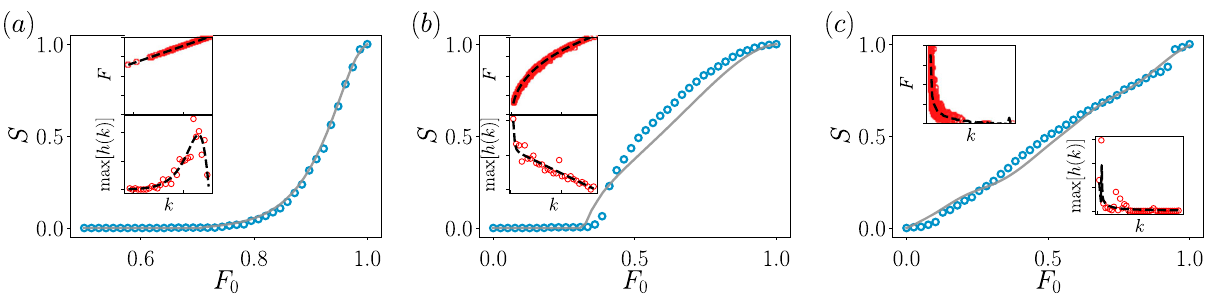
Fig. 6 Feature-enriched percolation of dynamical processes on top of real-world networks. In ( a ) mutualistic dynamics are given by Eq. (22), in ( b ) population dynamics from Eq. (23) and in ( c ) the biochemical dynamics (24) The main plots display the size of the largest connected component from simulations (markers) and its approximation given by the theory (lines). Insets show the data used to feed the Bayesian machine scientist (markers) and the resulting curves (dashed lines), used to calculate the degree-feature joint distribution (21). The output functions of the BMS are given in Supplementary Note 8. The feature is the value of the dynamical variable x i at the steady-state, normalized by its maximum value, i.e., F ¼ x i ð t ! 1Þ = max The range of F in all the insets is the unit interval. The range of max ½ h ð k Þ(cid:5) is arbitrary since its values depend on the binning to compute the histograms. All constants { τ i } are set equal to 1. The initial condition is a uniform distribution in the unit interval. Each point of the main plot is computed as the average of 100 independent realizations of